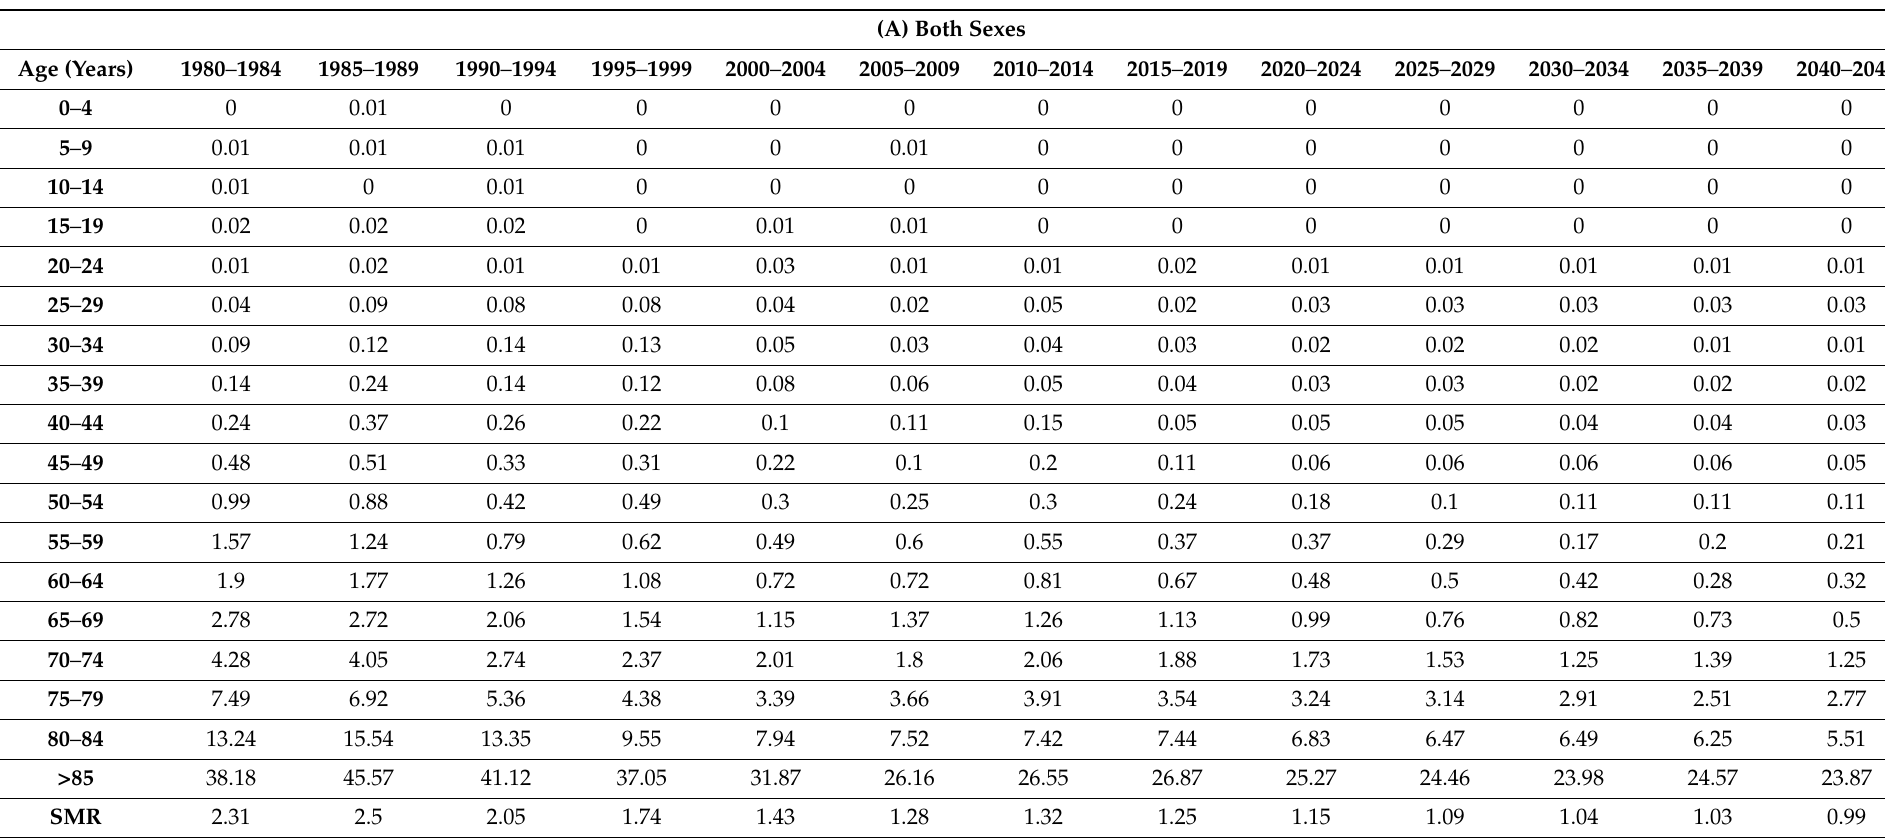
Table 2. Age-specific mortality rates per 100,000 inhabitants (European population 2013) observed (1980–2019) and projected (2020–2044) by periods and age groups by NMSC in